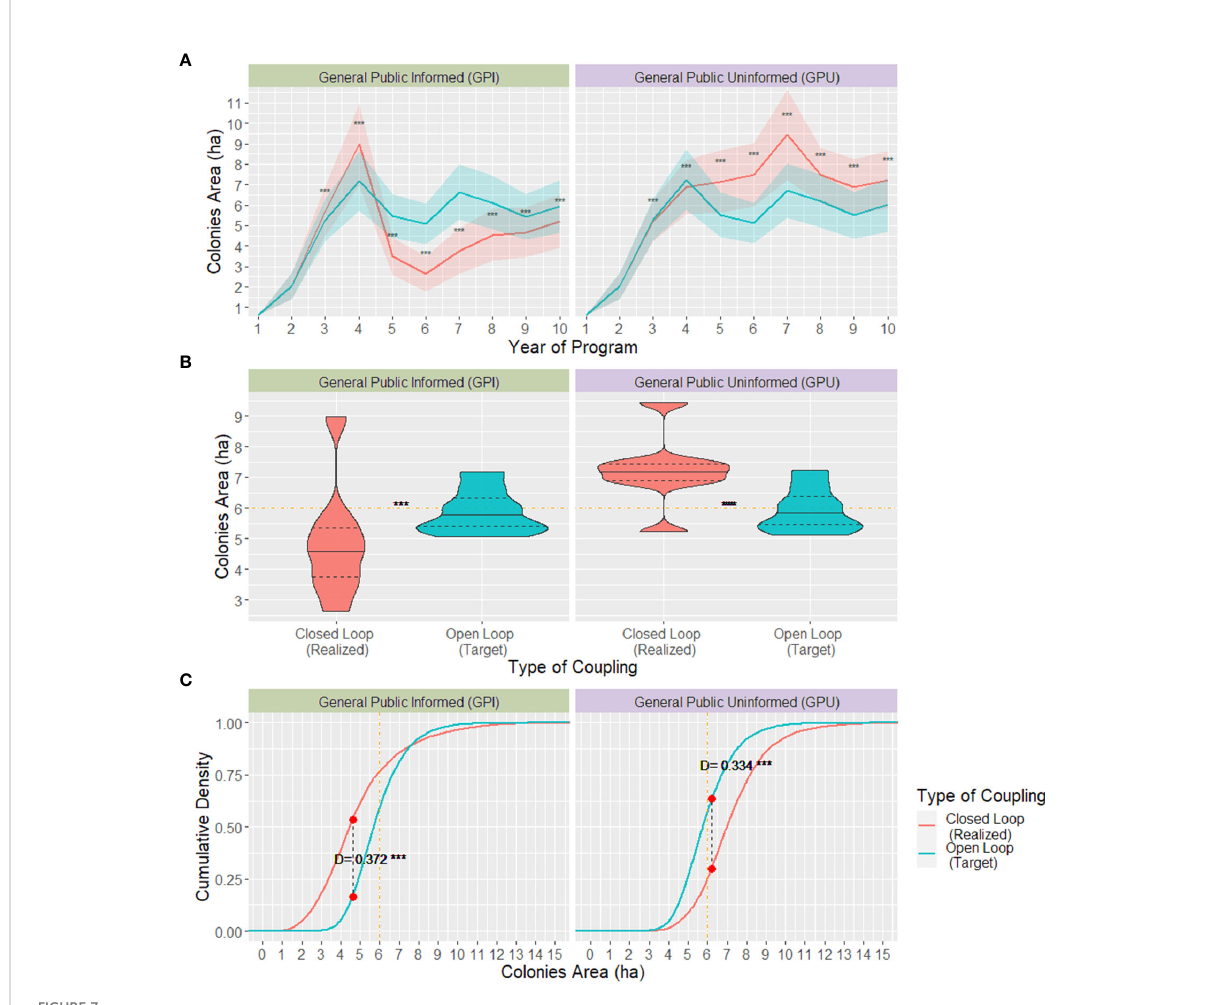
FIGURE 7 Overwintering Colonies. (A) Time series of target overwintering colonies ’ area using an open-loop coupling (teal) and realized colonies ’ area (salmon), as forecasted by the closed-loop coupling. (B) realized overwintering colonies ’ posterior distribution (salmon) against the target area (teal); Horizontal dashed line (orange) at 6 hectares represents the minimum recommended area for the overwintering colonies. (C) Cumulative distribution for the realized (salmon) and target (teal) overwintering colonies posterior; Vertical dashed line (orange) at 6 hectares represents the minimum recommended area for the overwintering colonies. A vertical dashed line (black) with red circles represents the maximum distance between both distributions ( “ D ” ) as estimated by the Kolmogorov – Smirnov test. ***1% signi fi cance level with two-tailed t-Test for panel (A – C) and Kolmogorov – Smirnov test for panel (C)